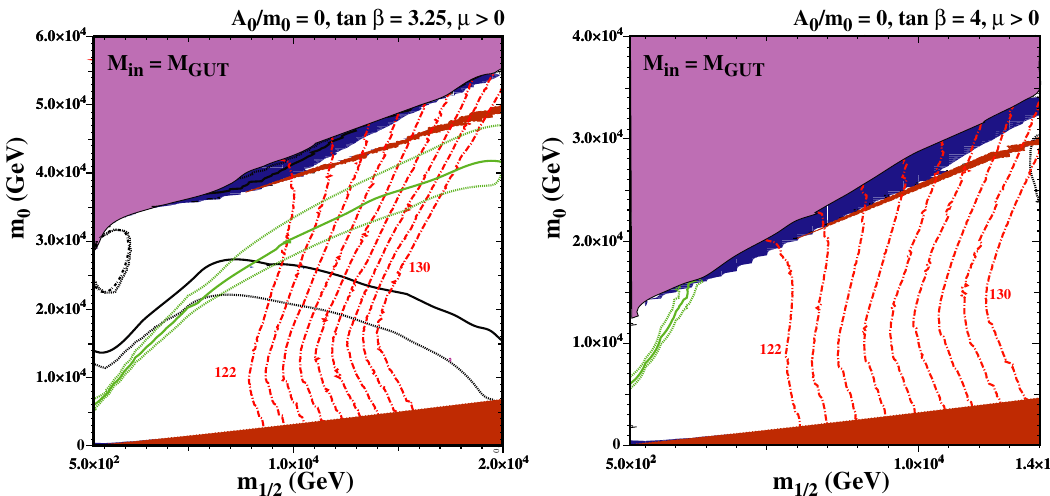
Fig. 12 Two ( m 1 / 2 , m 0 ) planes in the focus-point region of the CMSSM for tan β = 3 . 25 (left panel), tan β = 4 (right panel), μ > 0 and A 0 / m 0 = 0. The black lines are contours of the p → K + ¯ ν life- time, as calculated varying the GUT phases to minimize this decay rate,